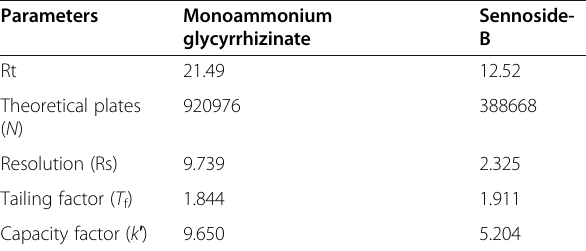
Table 4 System suitability parameters of the formulation